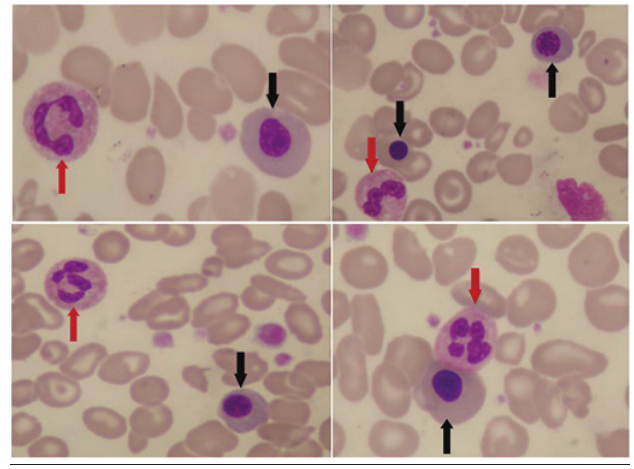
figurE 2 − A peripheral blood smear (100×): Leishman’s stain indicating leukoerythroblastic picture in a case of BMN. Black arrows show nucleated erythrocyte precursors, with red arrows indicating granulocytes BMN: bone marrow